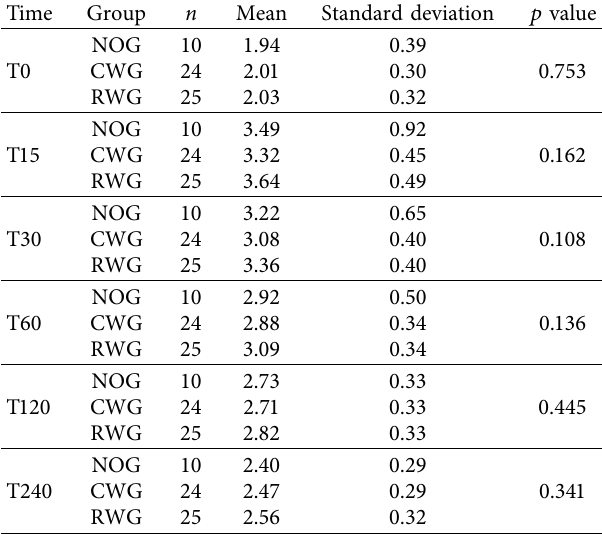
Figure 2: Blood magnesium: comparison of mean concentration throughout the study. RWG, real body weight group; NOG, nonobese group; CWG, corrected ideal body weight group; CG, control group. Table 2: Mean and standard deviation of blood magnesium concentration in three groups over time (mg dL − 1 ).